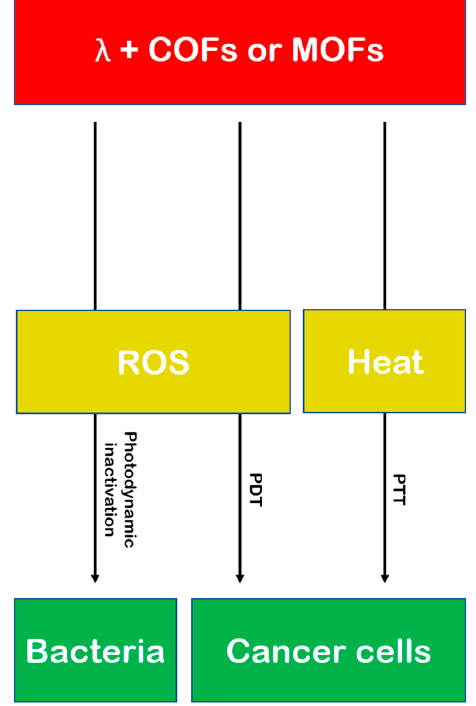
Figure 3. Photodynamic (PDT) and photothermal (PTT) therapy, with COF or MOF agents, against bacteria and cancer cells.